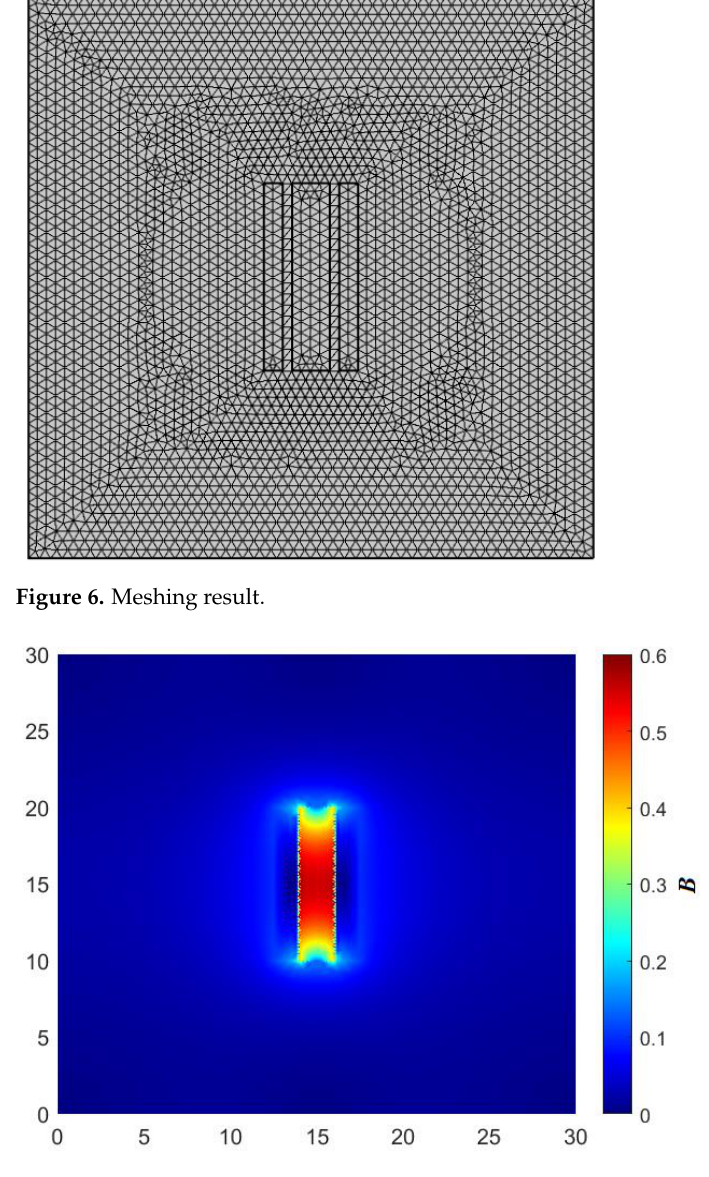
Figure 7. Finite element calculation result.